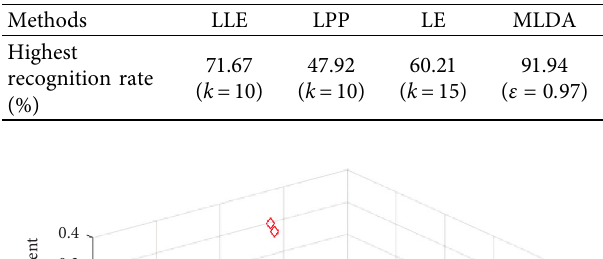
Table 4: Highest recognition rate under different distance manifold learning